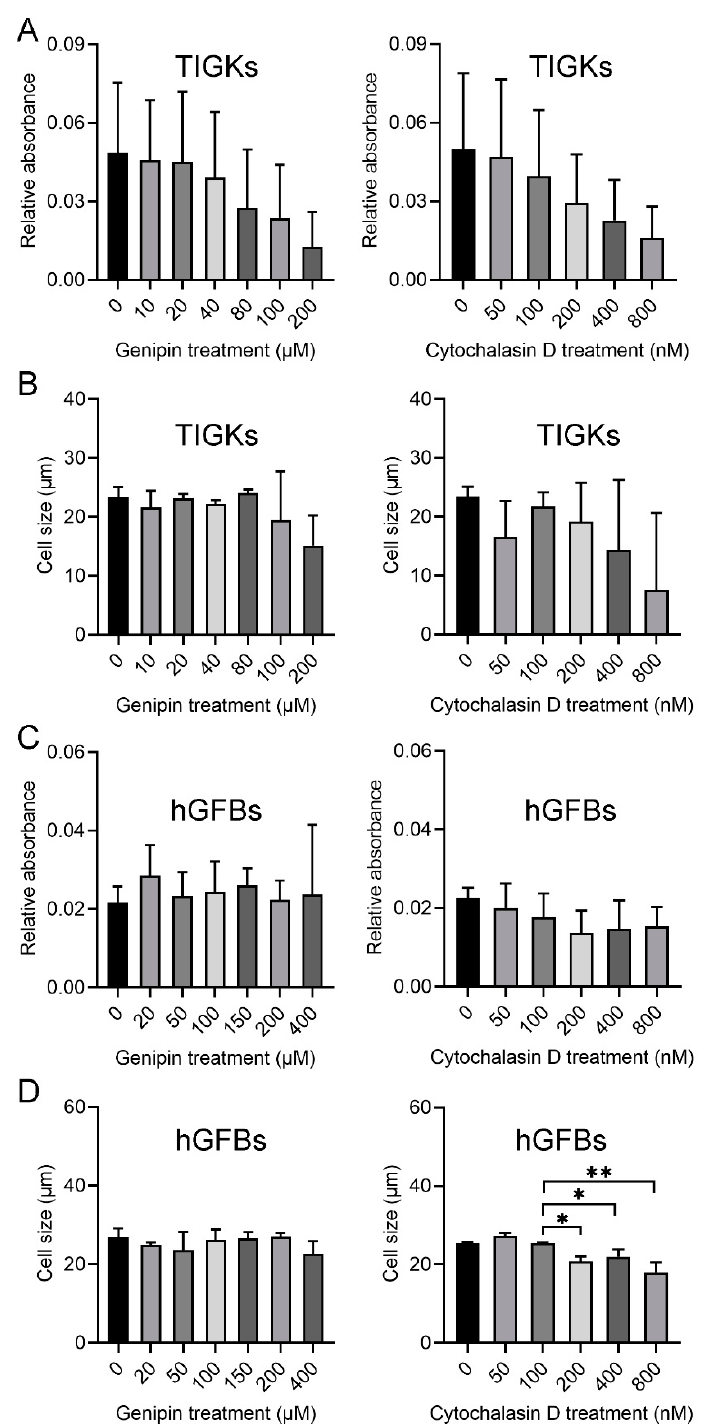
Figure 1. Evaluation of genipin or cytochalasin D toxicity for the TIGKs/hGFBs in the 2D monolayer culture. ( A ). MTT assay of the TIGKs after treatment with different concentrations of genipin or cytochalasin D. ( B ). Cell size of the TIGKs after treatment with different concentrations of genipin or cytochalasin D. ( C ). MTT assay of the hGFBs after treatment with different concentrations of genipin or cytochalasin D. ( D ). Cell size of the hGFBs after treatment with different concentrations of genipin or cytochalasin D. Abbreviations: hGFBs: hTERT-immortalized gingival fibroblasts; TIGKs: hTERT-immortalized gingival keratinocytes. *: p < 0.05, **: p ≤